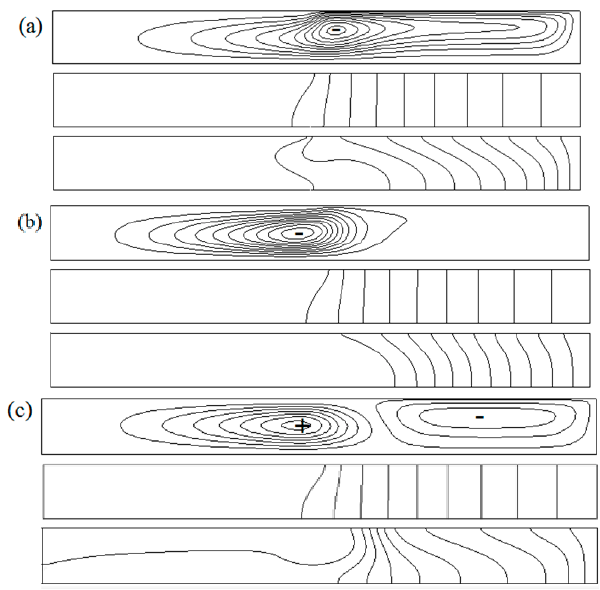
Figure 5. Flow structures (upper), isotherms (middle) and iso-concentration lines (bottom) in the meridional plane when the crucible rotation is considered and Re T = 400. ( a ) Re c = 468, Ψ max( − ) = 0.22; ( b ) Re c = 1403, Ψ max( − ) = 0.81; ( c ) Re c = 468, Re s = 468, Ψ max( − ) = 0.15, Ψ max(+) = 0.36.